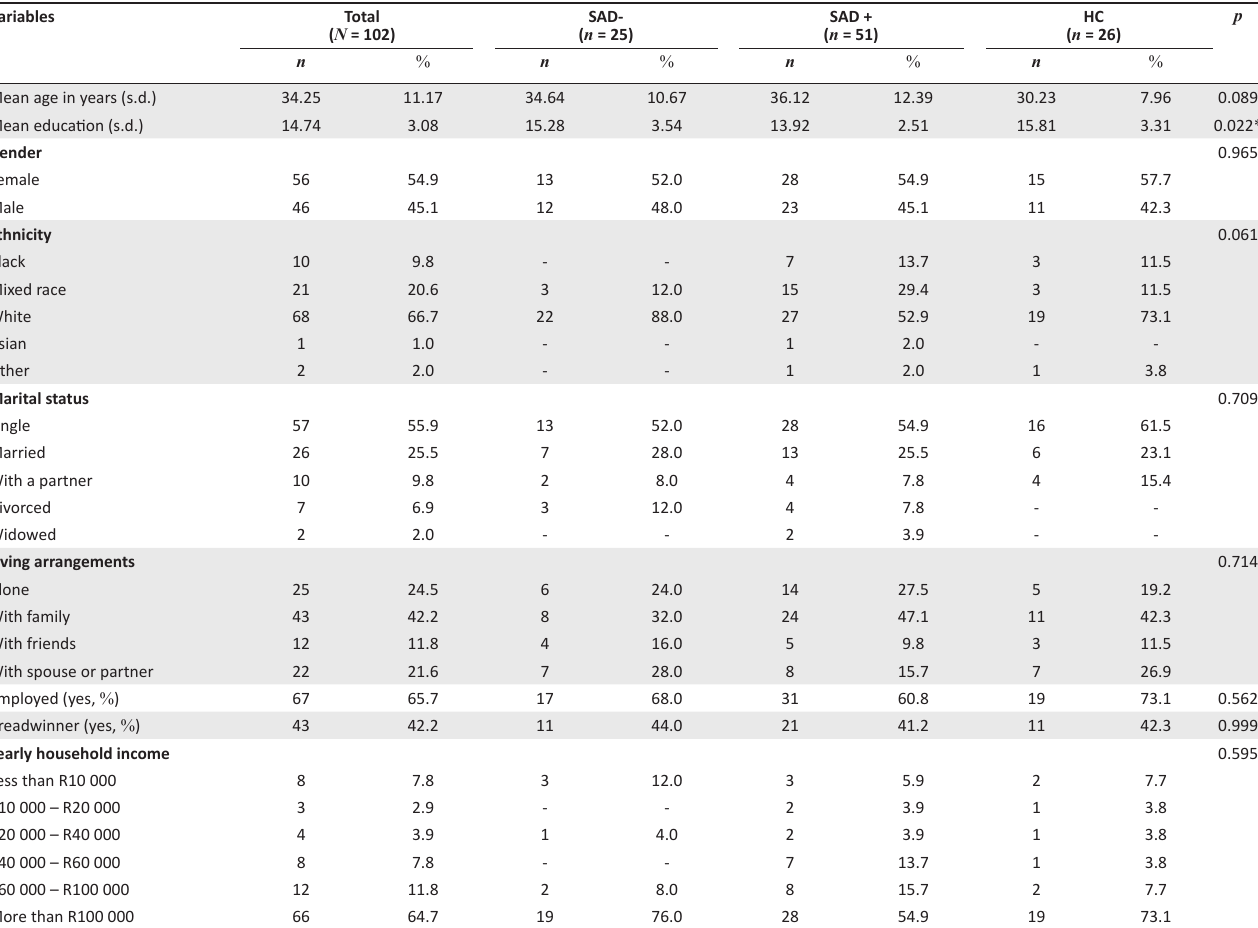
TABLE 1: Demographic data of the total sample and per patient group.